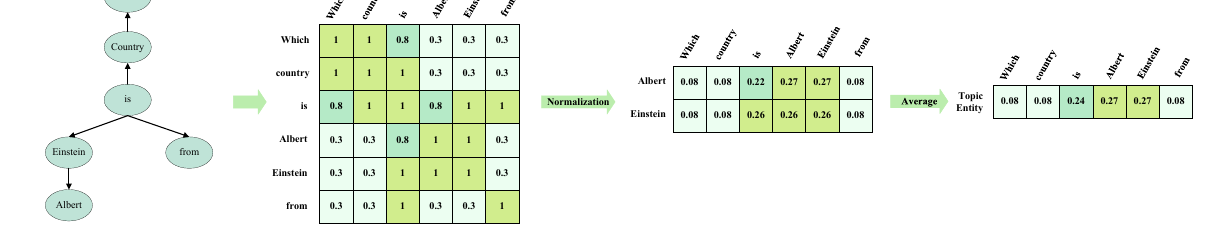
Figure 3. Dependency matrix generation example, where α = 0.8 and ε = 0.3. For the sentence “Which country is Albert Einstein from”, there is a weak dependency between “is” and “Albert” and a strong dependency between “is” and “from”. After generating the dependency matrix, we need to select the vectors corresponding to this topic entity, normalize the vectors by rows, and then average them by